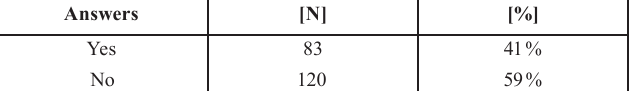
The Use of RFID System in the Surveyed Companies: Opinion of Respondents